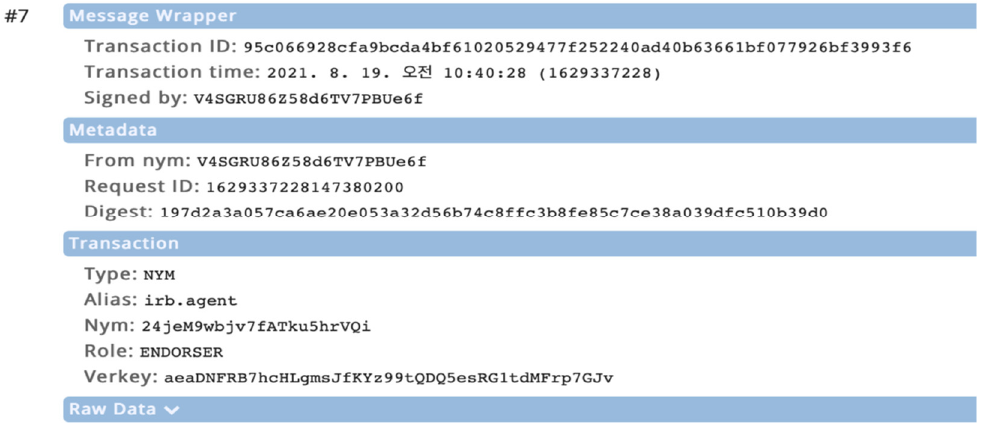
Figure 10. The result of a transaction when registering a researcher in von-network.